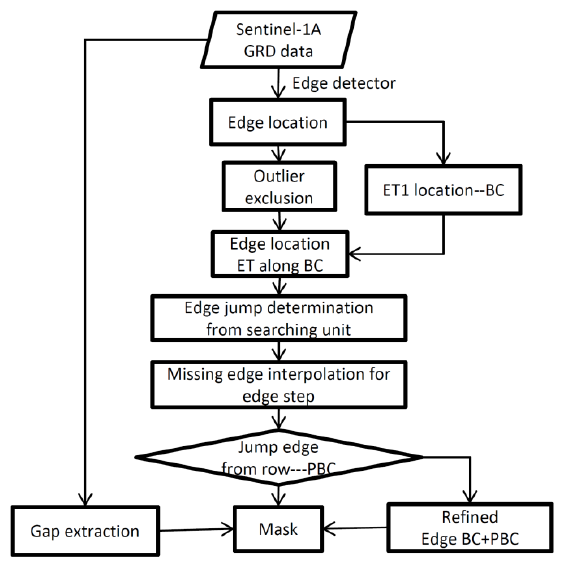
Figure 5. Sketch plot for edge detection process. In this figure, ‘BC’ indicates the direction from the image boundary to the image center, the same as what is defined in the context. ‘PBC’ indicates the direction perpendicular to the ‘BC’ direction perpendicular to the ‘BC’ direction.